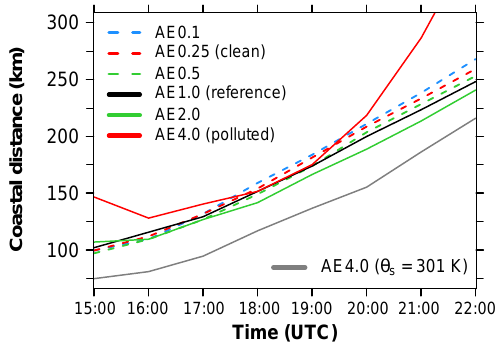
Figure 11. Temporal evolution of the inland propagation of the AI front via the distance from the coast (km) on 2 July 2016 between 15:00 and 22:00UTC, spatially averaged over Ivory Coast (7.5– 3.0 ◦ W) for the six experiments in Table 1. Dashed lines denote realizations with aerosol amounts below that of the reference case (black solid). The gray line shows the frontal propagation of the polluted case by using θ s = 301K instead of 302K for the front